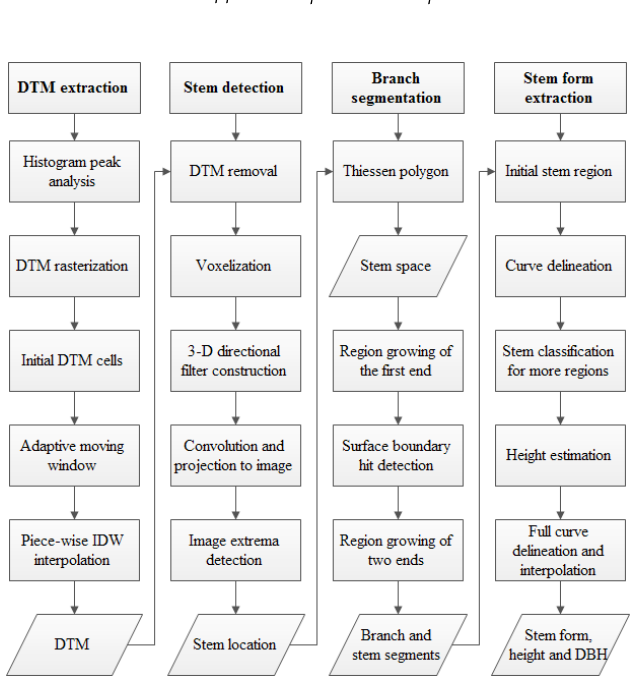
Figure 1. Flow-diagram overview of methods used to automatically extract plot-level tree stem attributes. DTM: digital terrain models; IDW: inverse distance weighted; DBH: diameter at breast height.